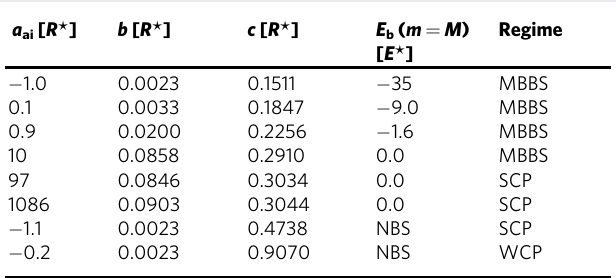
Table 1 Parameters of the regularized atom – ion interaction